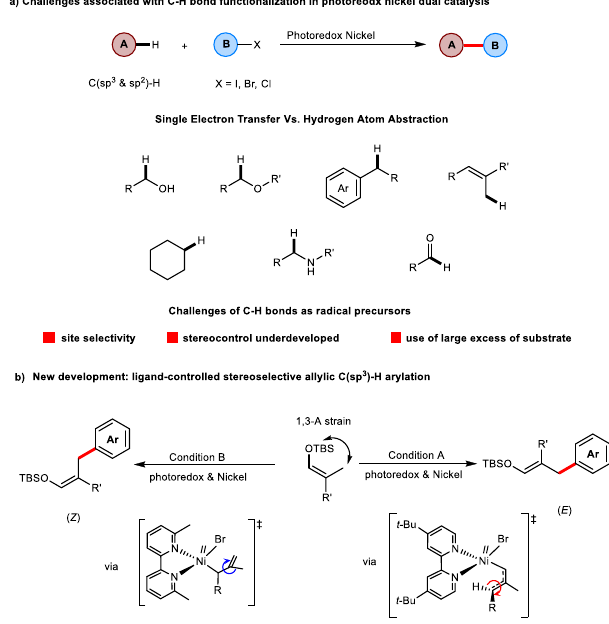
Fig. 1 | Reaction development. a Current developments in photoredox nickel synergistic catalysis enabled C – H bond functionalization. b our initial design and development of a stereodivergent arylation.